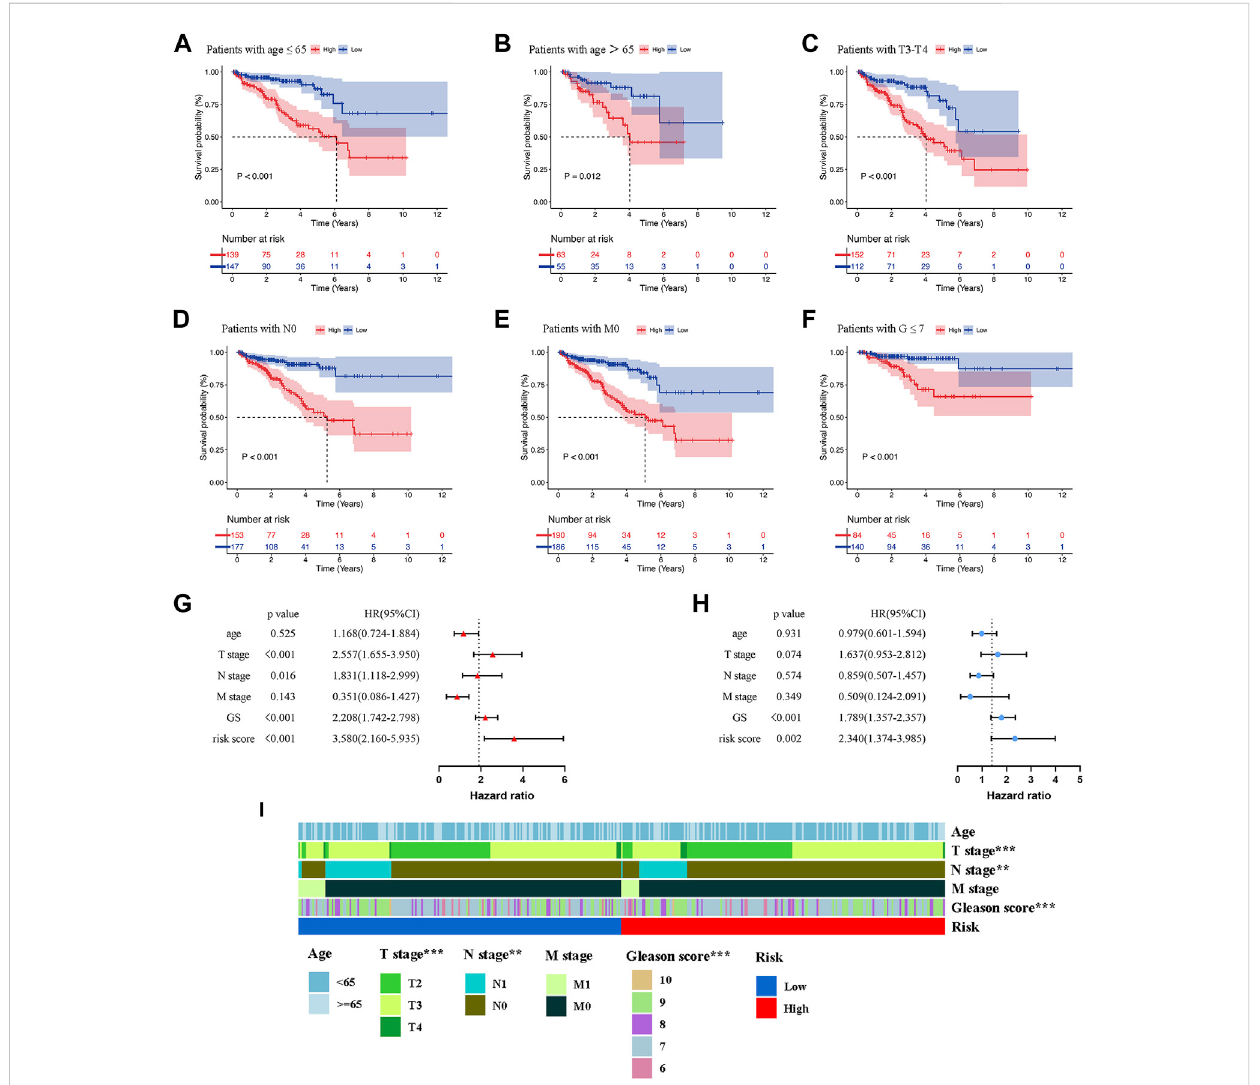
FIGURE 5 Kaplan-MeiersurvivalanalysisofBCRinthelow-andhigh-riskgroupsforpatientswithage ≤ 65 (A) ,patientswithage > 65 (B) ,patientswithT3-T4 (C) , patients with N0 (D) , patients with M0 (E) , patients with G ≤ 7 (F) . Univariate (G) and Multivariate Cox regression (H) con fi rmed that the risk score and GS were independent prognostic factors of BCR of PCa patients. (I) The correlations between the prognostic model and clinicopathologic variables (age, TNM stage, and Gleason score). ** p < 0.01; *** p <